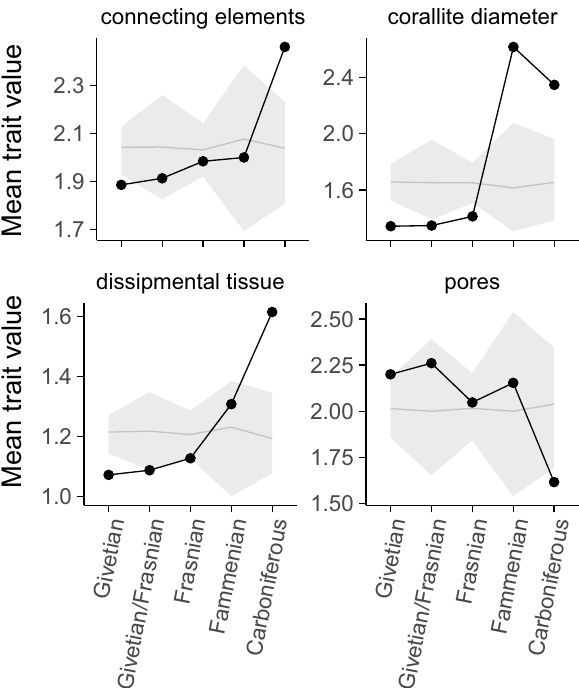
Figure 4. Directional change in mean trait values for ordered categorical traits through time. Grey lines indicate expected trait means based on random permutations. Movement outside the grey ribbon indicates non- random change, and a point outside the ribbon shows that trait values of the assemblage at that time are more distinct that 95% of the random expectations. Trait values refer to the character states in Table